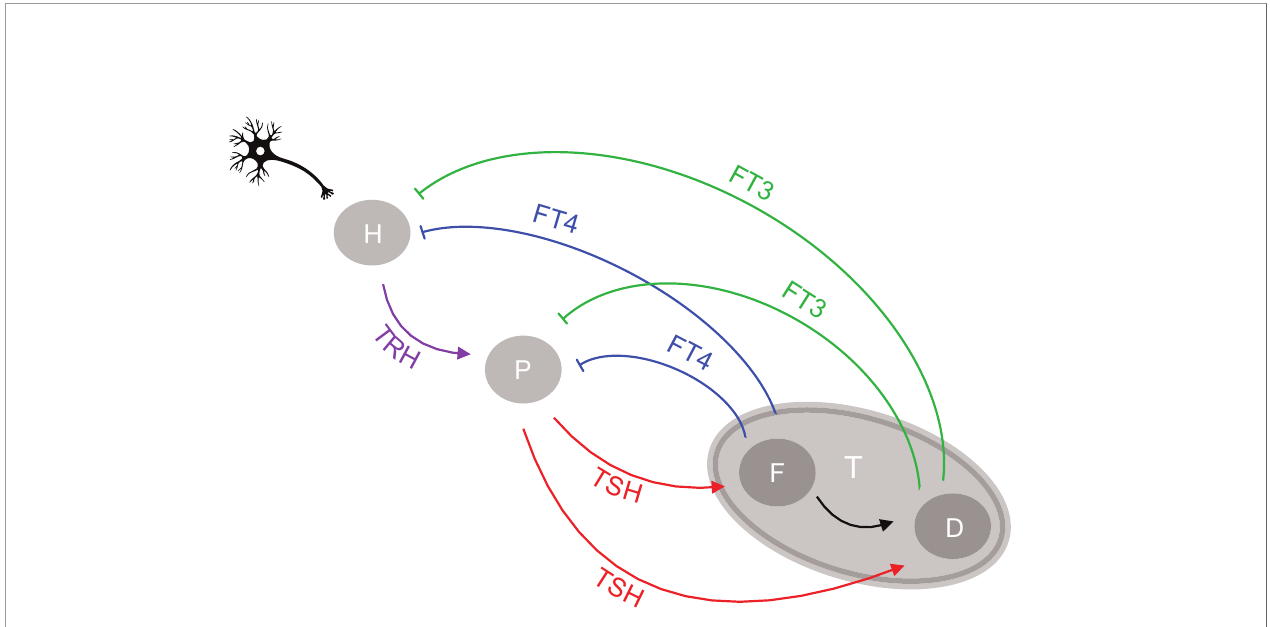
FIGURE 1 | Network of the hypothalamic-pituitary-thyroid axis regulation. Afferent signals project to the hypothalamus from higher brain centers. The hypothalamus (H), pituitary (P), and thyroid gland (T) communicate through an interactive network of positive feedforward (arrows) and negative feedback loops (bars), involving as signals the respective hormones produced and released by each gland into the circulation, namely TRH by the hypothalamus, TSH by the pituitary and T4 and T3 by the thyroid gland. T3 is both synthesized de novo in the thyroid follicular cell (F) and converted from T4 as a precursor by deiodinases (D). The circulating free forms of T4 and T3 are referred to as FT4 and FT3,